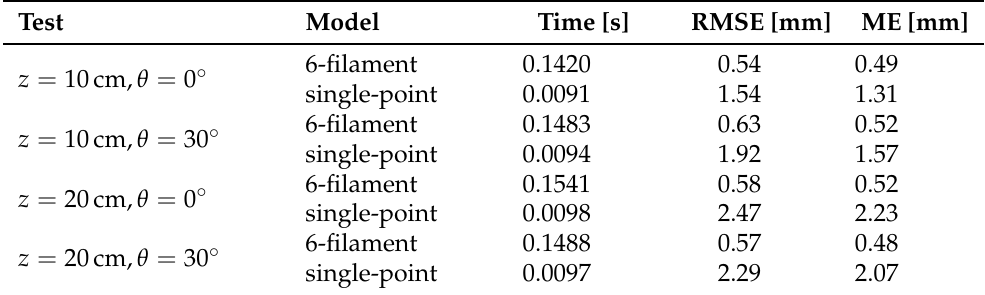
Table 4. Speed and accuracy of the 6-filament and the single-point models used in a real electromagnetic tracking experiment. Scatter plot of the error is shown in Figure 15. Computation time is calculated as the average solution time for the 49 test